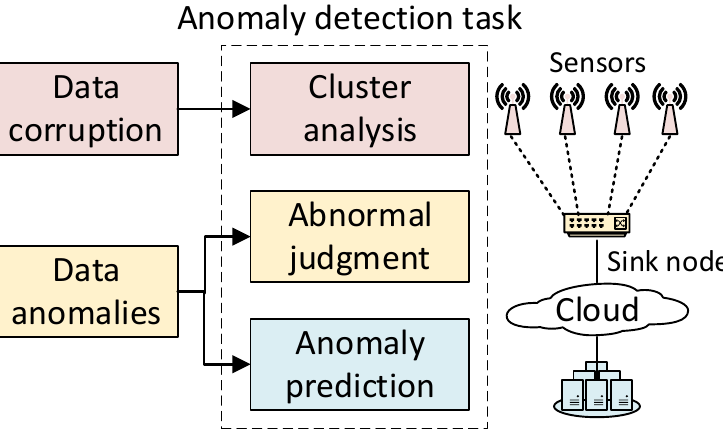
Figure 2. Edge computing model in underground